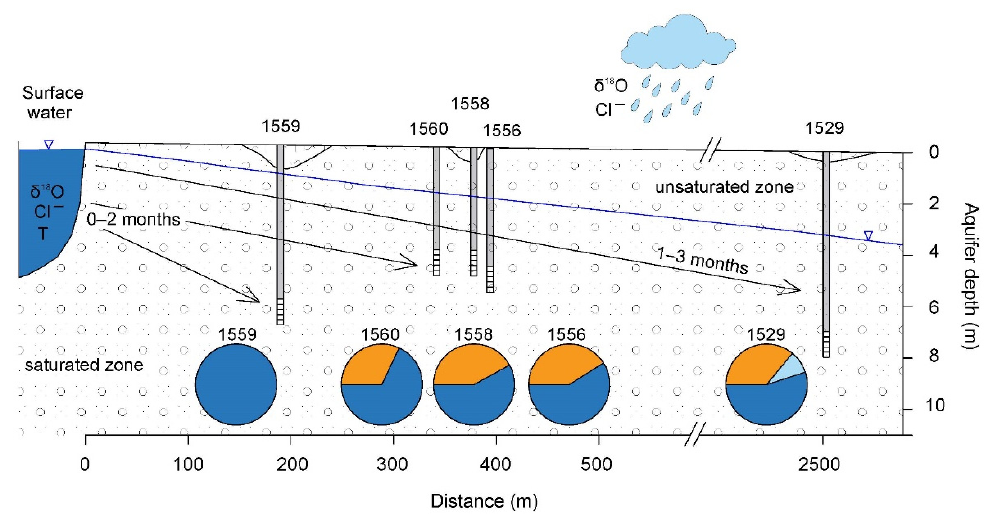
Figure 7. Conceptual model of the groundwater recharge at the NW part of the Varaždin aquifer. Pie charts represent recharge share for each observation well from surface water (blue color), precipitation (light blue color), and interchangeable recharge depending on hydrological conditions (orange color).